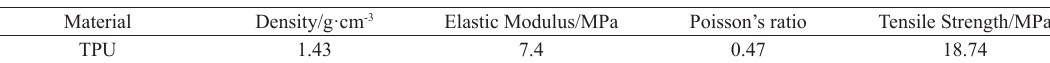
Table 2. TPU material